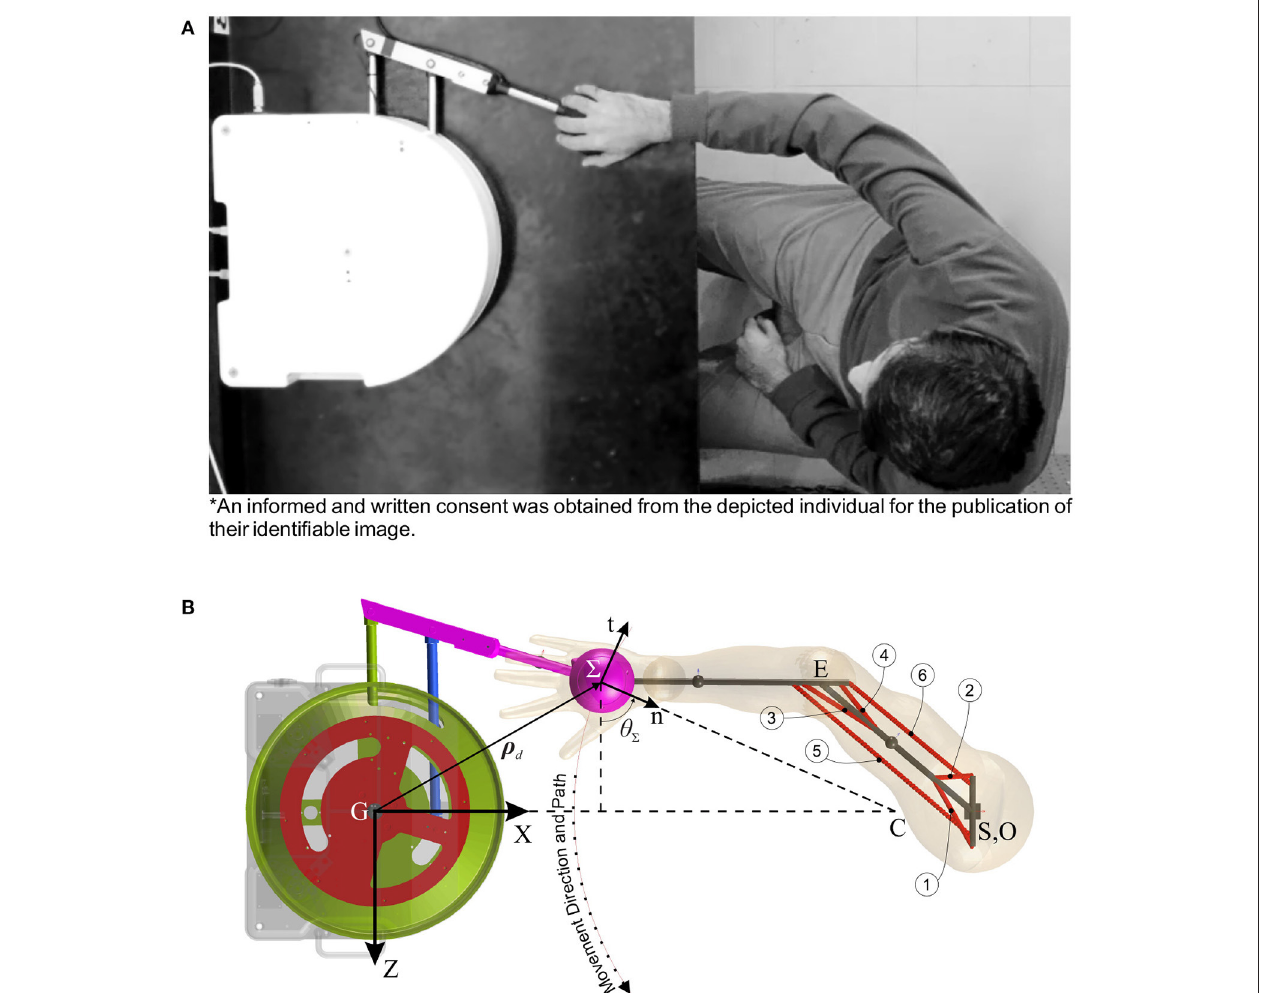
FIGURE 1 | Human-robot rehabilitation system. (A) Experimental setup (an informed and written consent was obtained from the depicted individual for the publication of their identifiable image). (B) MapleSim TM model (circled numbers show the corresponding muscle